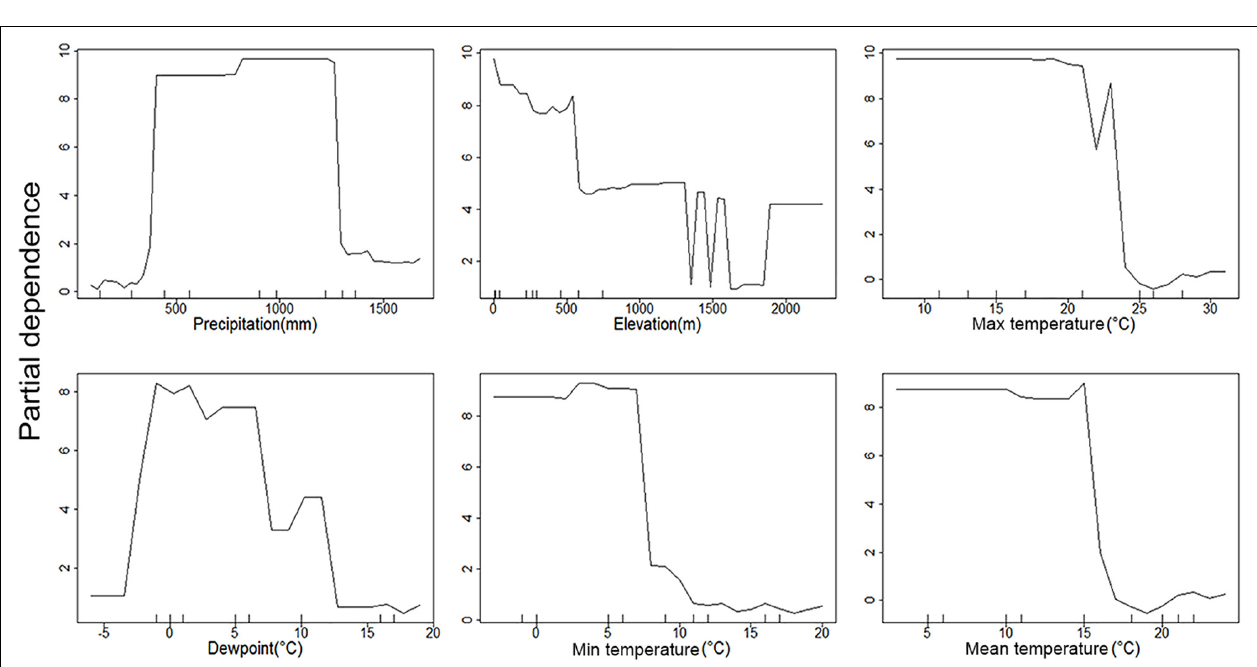
FIGURE 6 | Partial dependence plots of environmental parameters showing their association with C . quinquefasciatus occurrence. Y-axis is partial dependence to accurately predict C . quinquefasciatus occurrence.